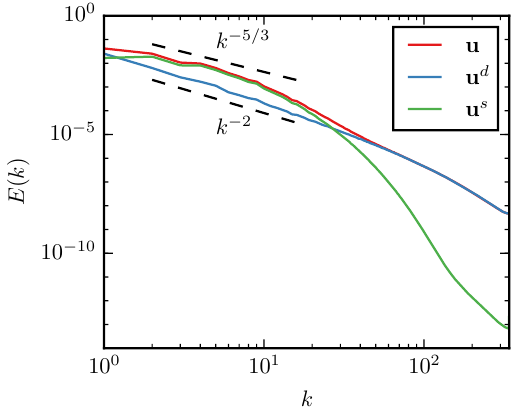
Figure 3. Spectra of velocity ( u ) and its dilatational and solenoidal ( u d and u s , respectively) components from Run 1. The reference dashed black lines have slopes of